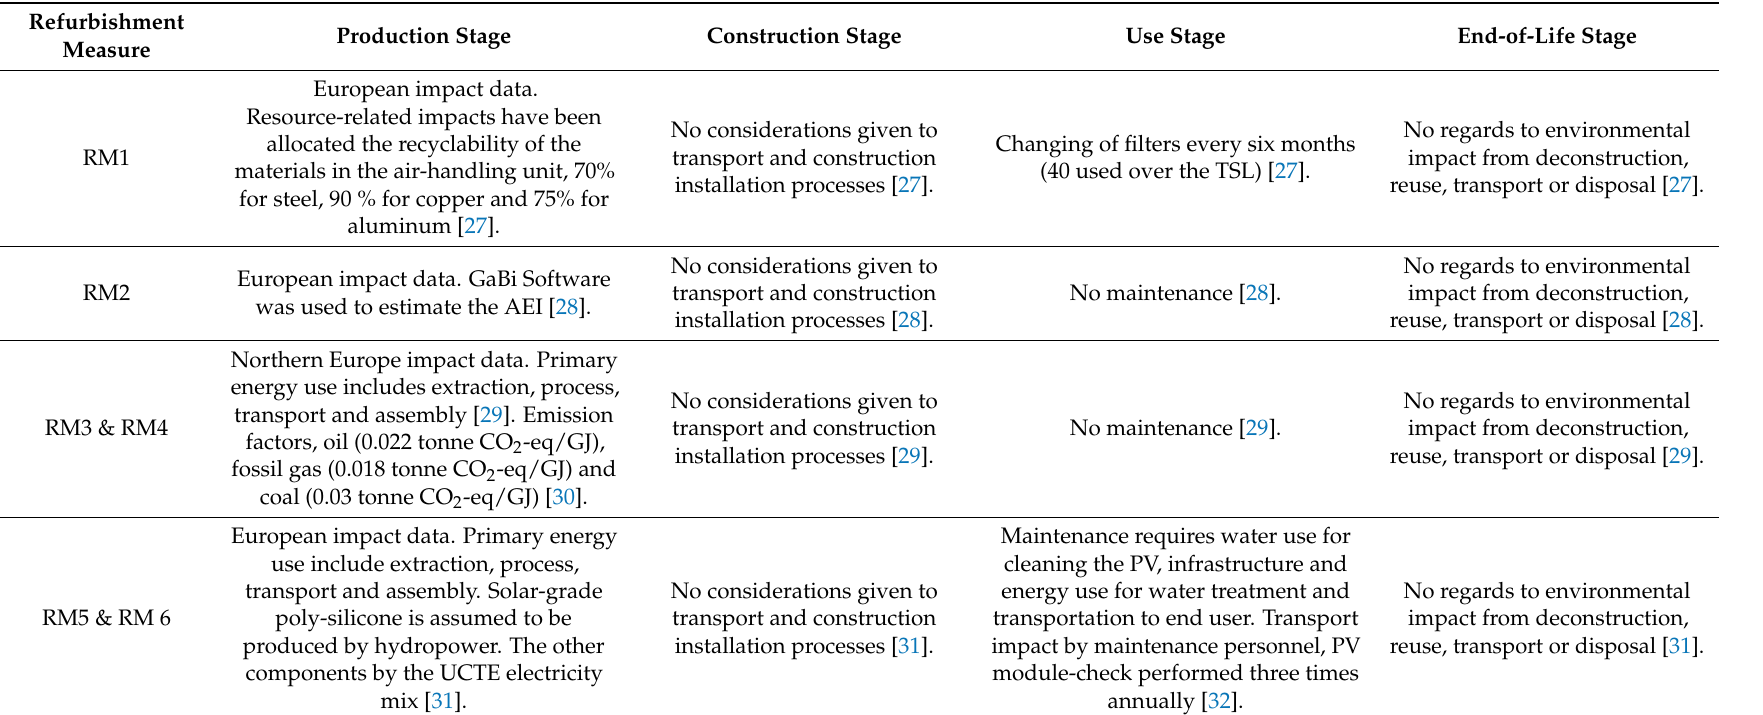
Table 2. Inventory analysis based on the EN 15978:2011